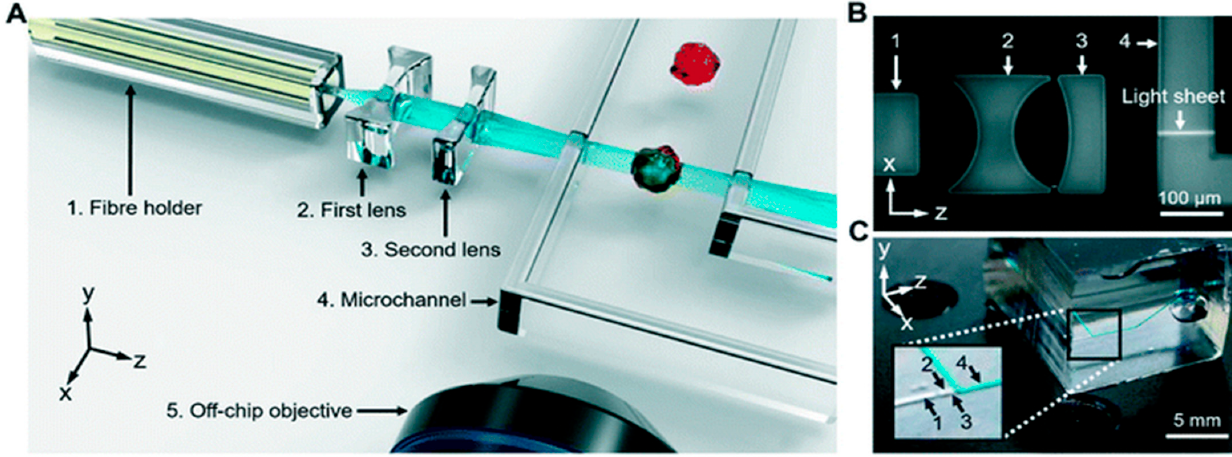
Figure 8. Panel ( A ) is a schematic of light-sheet fluorescence microscopy (LSFM) on a microfluidic device. Panel ( B ) represents a micrograph of the optical setup and panel ( C ) represents a photograph of the microfluidic device being imaged. Reproduced from [81] with permission, © 2021 Royal Society of Chemistry.